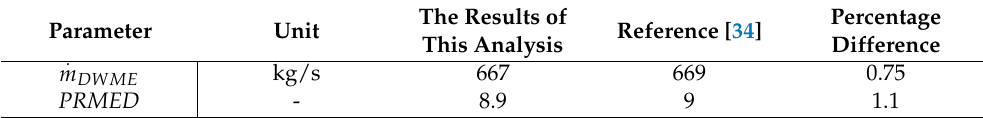
Table 7. Validation results for the MED system.